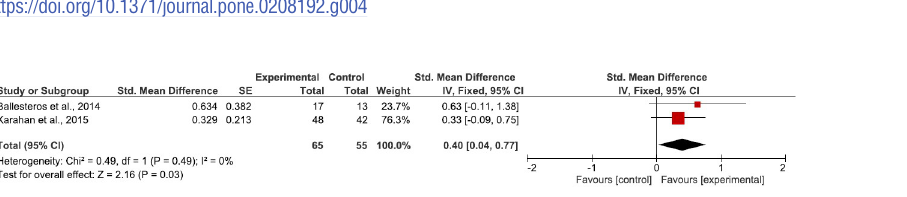
Fig 5. Forest plot of comparisons: Experimental vs. control group change in social